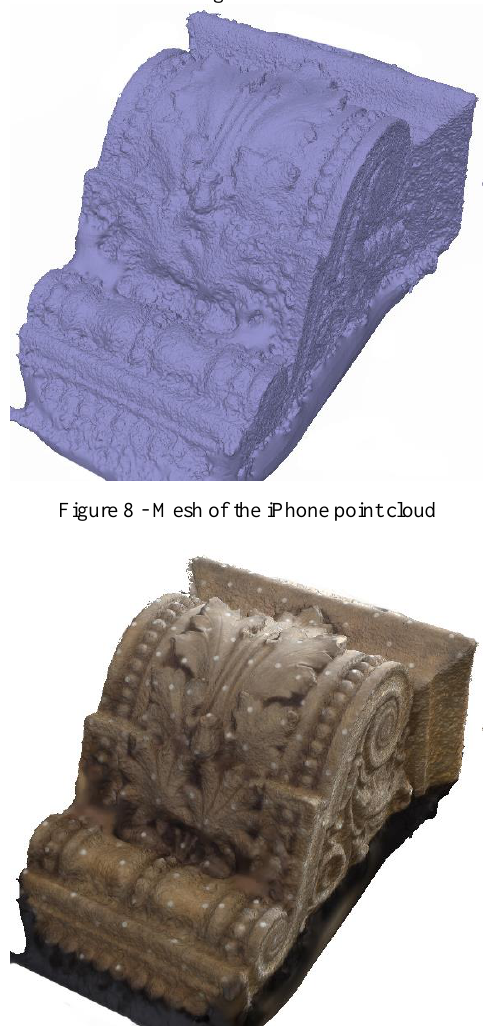
Figure 9 - Textured mesh of the iPhone point cloud The four models generated were different in terms of number of points and precision of the mesh. In Table 3 the data about the four devices are reported.